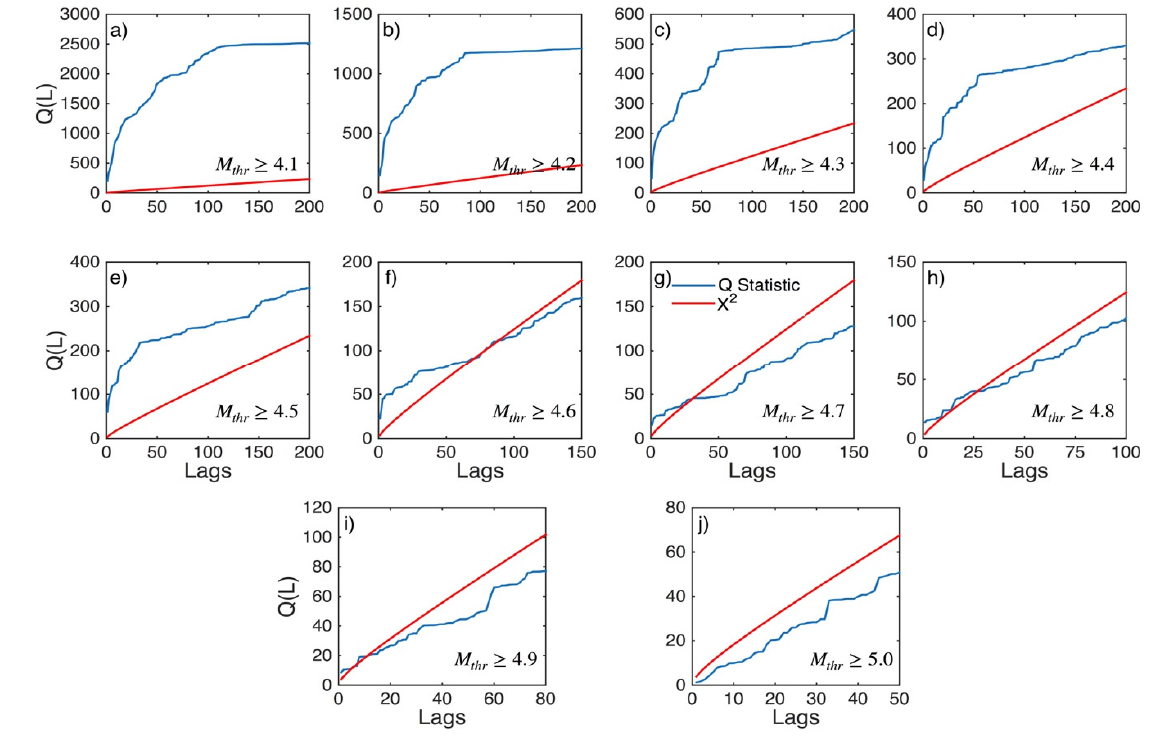
Figure A24. Statistics of Ljung–Box Q-test (blue lines) and the critical values for the X 2 distribution (red lines) for North Aegean Sea (sub-area 9) for magnitude thresholds ( M thr ) varying from 4.1 to 5.0 (subplots a – j ).